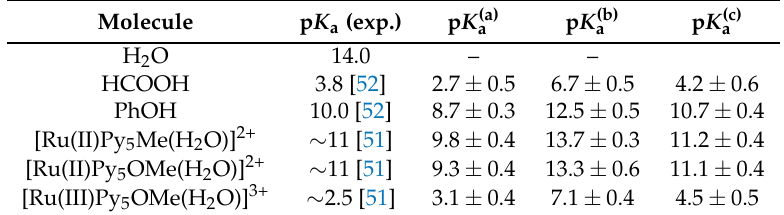
Table 2. All results presented here are calculated at 320 K, for a cubic box with side length of 15.6406 Å and a cutoff R C = 1.24 Å, over a trajectory of about 20 ps (where the first 5 ps were not included in the evaluation). The standard deviation is calculated using the block average method with a block size of 1 ps; (a) absolute, (b) relative, (c) probabilistic protocols.